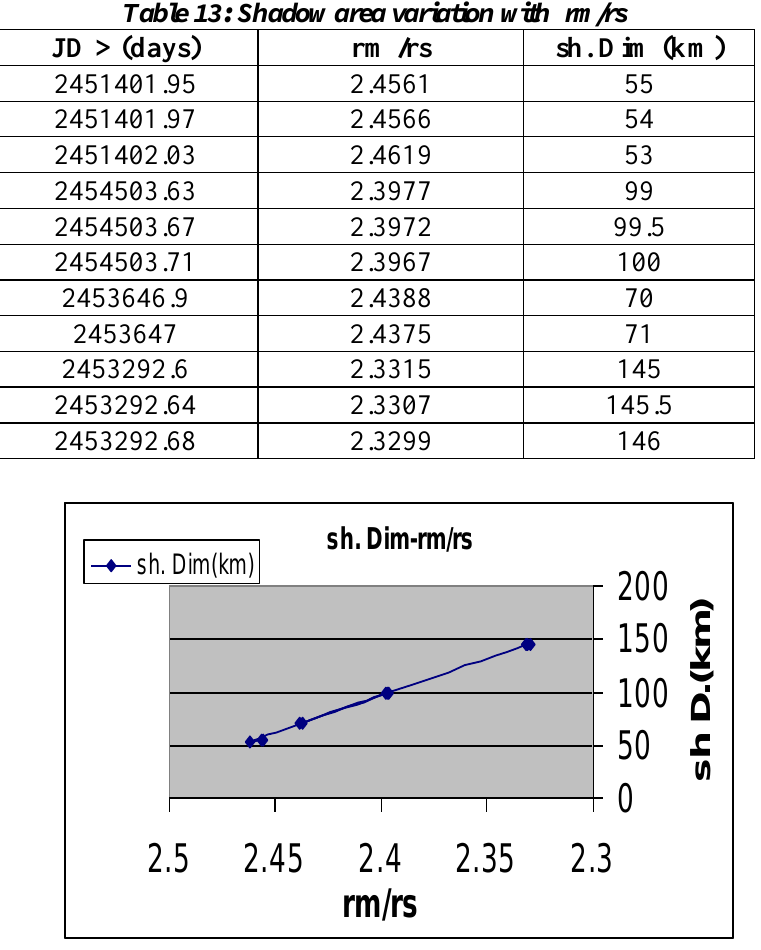
Fig.2: Shadow diameter variation with ratio